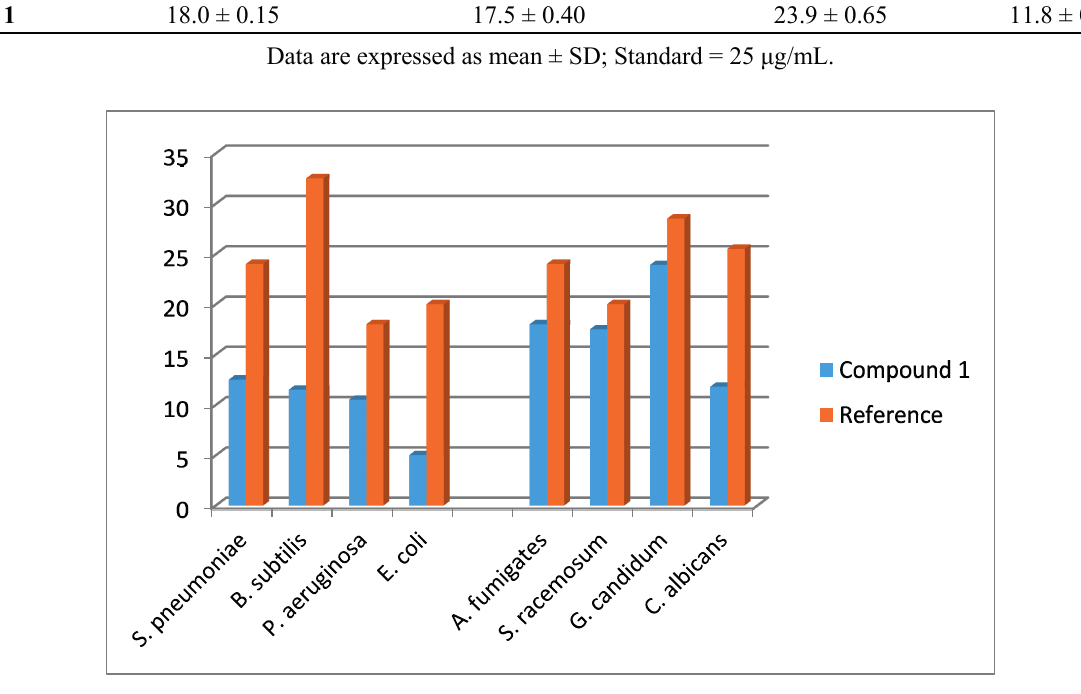
Figure 11. Inhibition zone results of the synthesized compound and the references